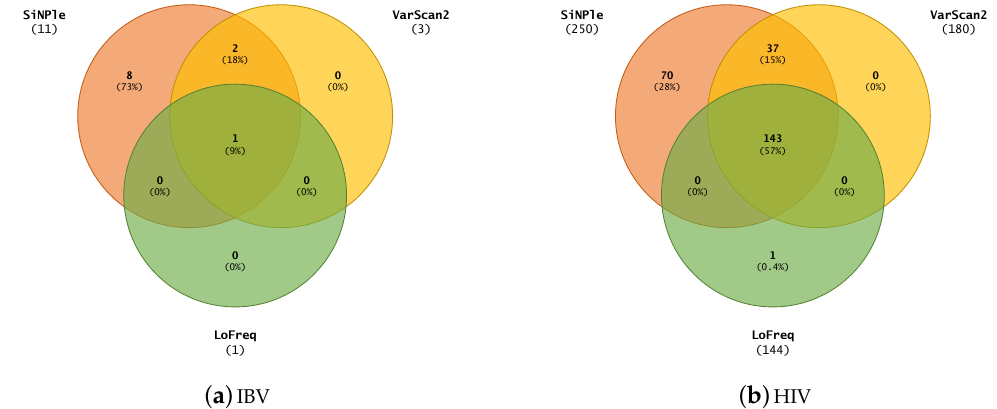
Figure 4. The comparison of variants discovered on IBV and HIV datasets using SiNPle, LoFreq and VarScan2 in their default